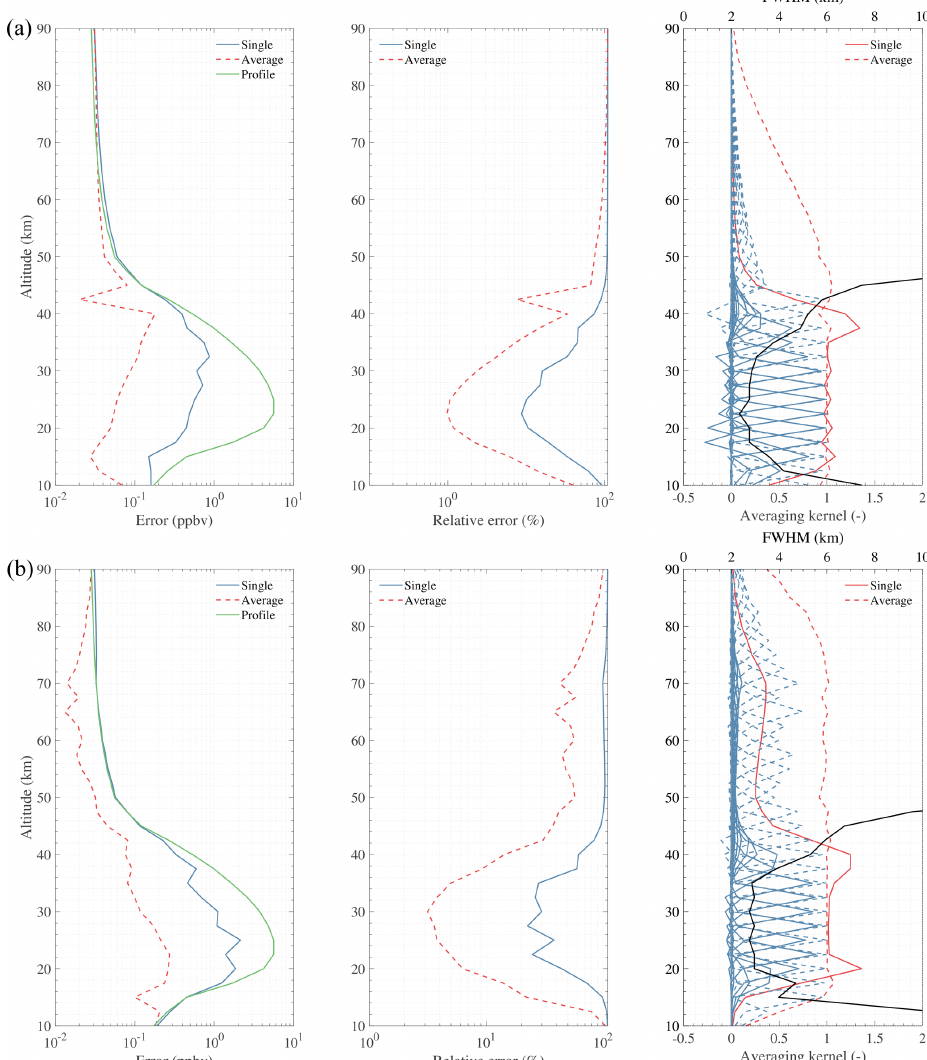
Figure 15. Simulation results of HNO 3 retrieval using 244 (a) and 656GHz (b) lines. “Single” and “Average” represent the retrieval error using different noise. “Profile” represents the typical profile used in the simulation. The black solid line in the last panel represents the FWHM (i.e. vertical